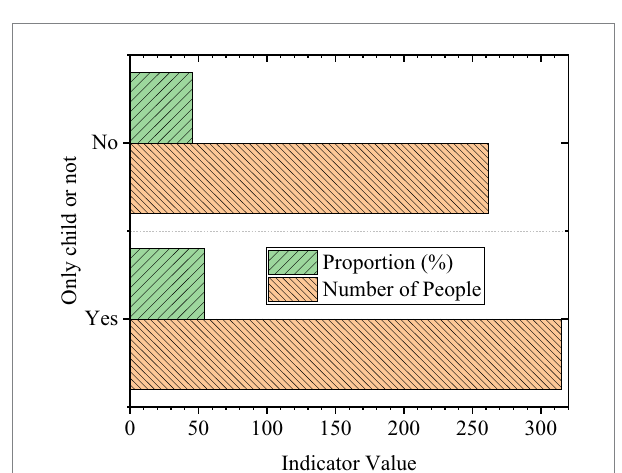
FIGURE 4 Situation of only child ( N =